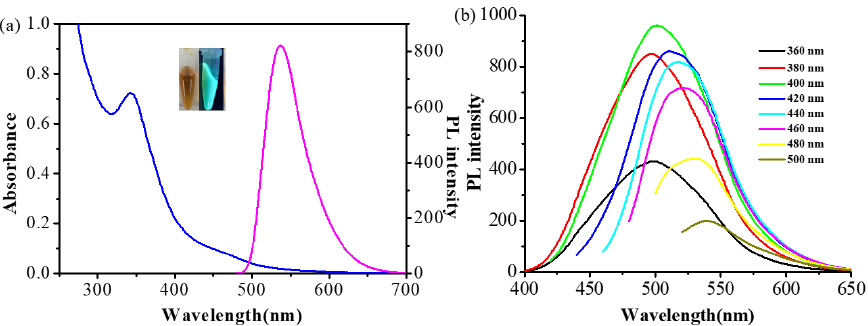
Figure 1. ( a ) UV-Vis spectrum and fluorescence emission spectrum of G-CDs; ( b ) Fluorescence emission spectra of G-CDs solution with different excitation wavelengths.